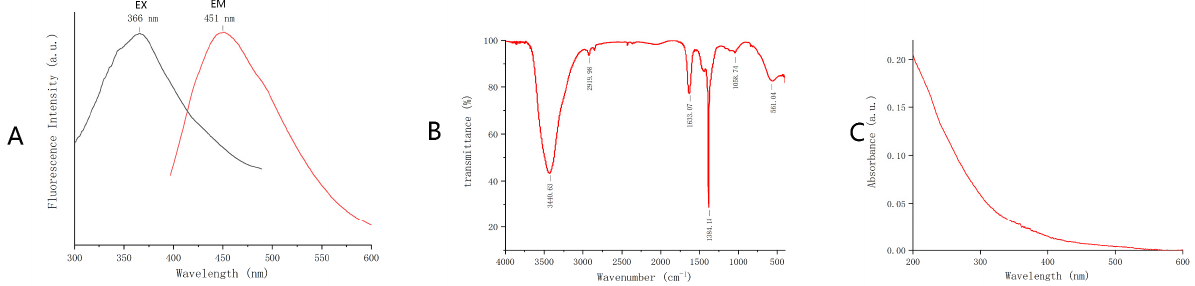
Figure 2. ( A ) Fluorescence spectrum. ( B ) FTIR spectrum. ( C ) Ultraviolet-visible (UV-vis)